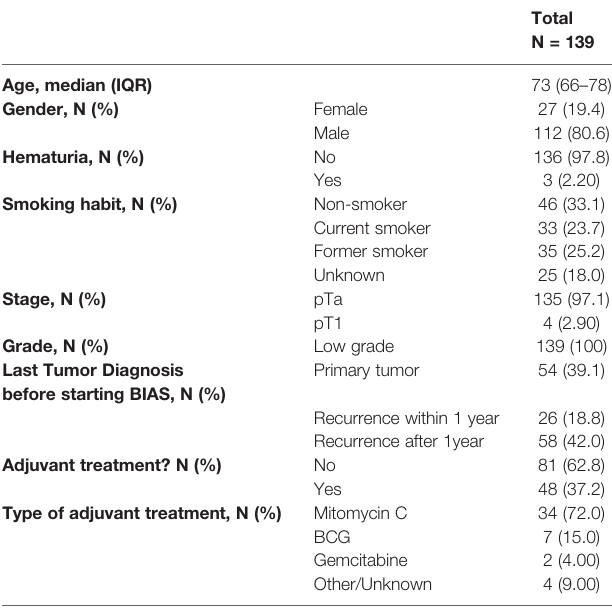
TABLE 1 | Baseline characteristics of the whole